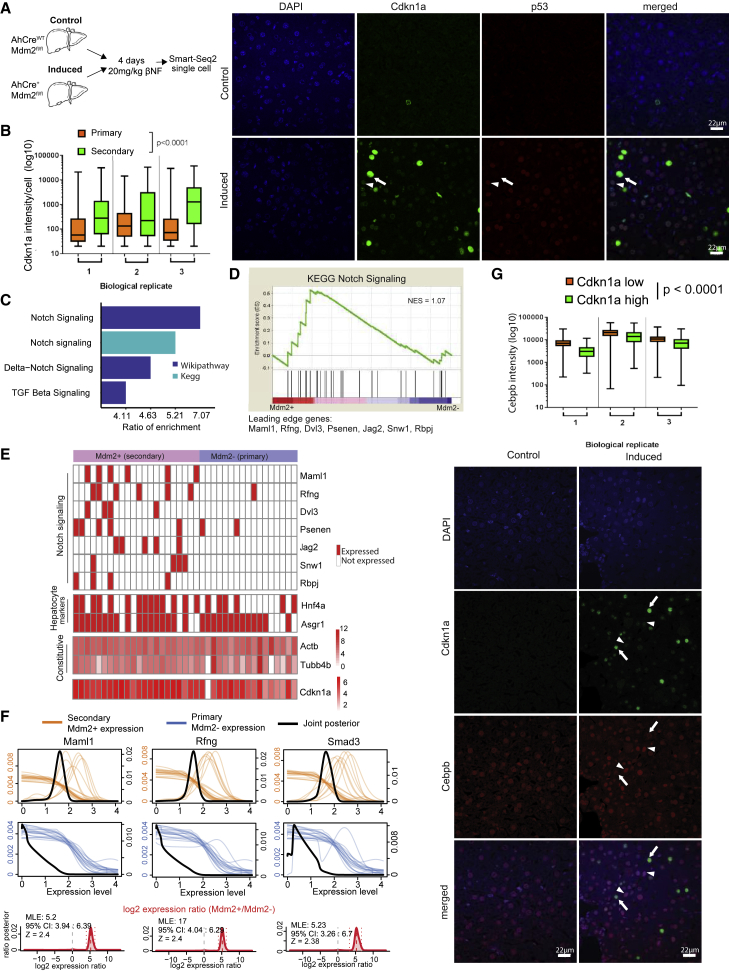
Notch Signaling Mediates Secondary Senescence In Vivo(A) Schematic representation of in vivo single-cell experiment.(B) Representative immunofluorescence images of liver section from induced AhCre+Mdm2fl/fl and control AhCreWTMdm2fl/fl mice stained for p53 and CDKN1A. Intrinsically induced senescence (arrowhead) and secondary senescence (arrow) are indicated. Boxplot for CDKN1A intensity in primary versus secondary senescent cells. (senescence: F[1,50291] = 2766, p < 0.0001; biological replicates: F[2,50291] = 283.2, p < 0.0001; senescence × biological replicates: F[2,50291] = 280.5, p < 0.0001, two-way ANOVA). Scale bar, 22 μm.(C) Pathway analysis for Mdm2+ (secondary) genes.(D) GSEA for Mdm2+/Mdm2− cells (NES = 1.07). Leading edge genes are indicated.(E) Heatmap for Notch pathway, hepatocyte markers, and Cdkn1a genes in Mdm2+ and Mdm2− cells. Constitutive genes and Cdkn1a were colored by their expression relative levels (binary: red expressed, white not expressed).(F) SCDE for Maml1, Rfng, and Smad3 in Mdm2+ cells (orange lines) and Mdm2− cells (blue lines). Joint posterior is marked by black line. Fold change of the genes in Mdm2+/Mdm2− is indicated in red, and dotted lines mark the 95% confidence interval. MLE, maximum likelihood estimation; CI, confidence interval; Z, Z score.(G) Representative immunofluorescence images of liver section from induced and control mice. Primary senescent cells (arrowheads) and secondary senescent cells (arrows) are indicated (CDKN1A: F[1,60145] = 353.3, p < 0.0001; biological replicates: F[2,60145] = 1044, p < 0.0001; CDKN1A × biological replicates: F[2,60145] = 8.96, p < 0.0001, two-way ANOVA). Scale bar, 22 μm.Related to Figure S4 and Tables S1 and S2.